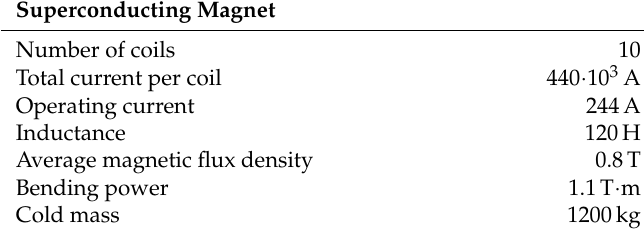
Table 2. Main characteristics of the superconducting magnet based on HTS ReBCO tapes proposed for